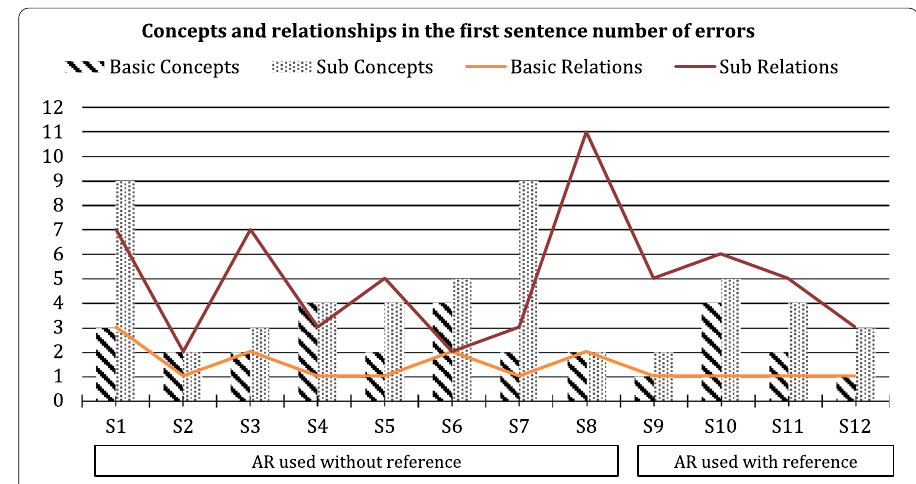
Fig. 6 Number of errors in concept and relationships in the first